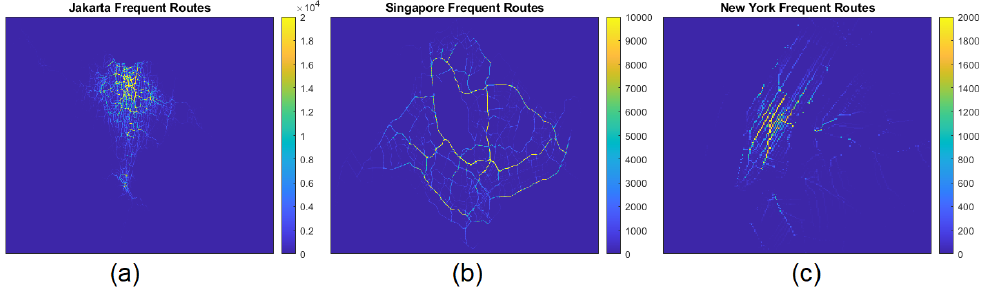
Figure 2. Frequent Routes for ( a ) Jakarta, ( b ) Singapore, ( c ) New